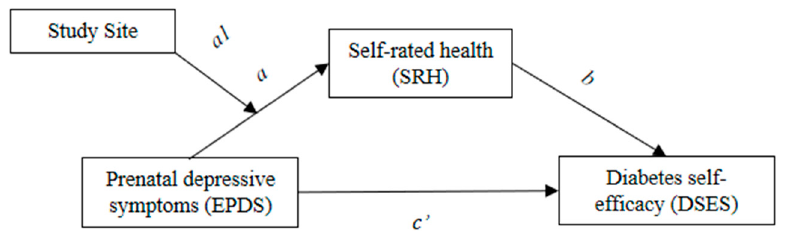
Figure 1. The figure shows the hypothesized mediating effect of self-rated health on the association between prenatal depressive symptoms and diabetes self-efficacy and the proposed moderating ef- fect of the study site.